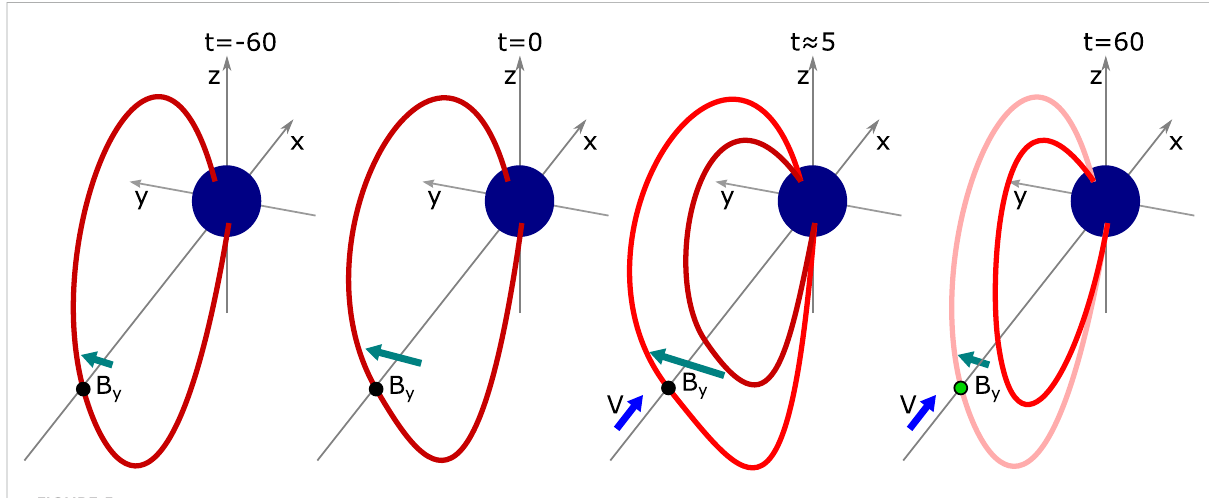
FIGURE 5 Con fi guration of magnetic fi eld lines in the magnetotail at different stages of the substorm. There is a small positive B y component at geosynchronous orbit (dark red fi eld line) when the loading phase commences ( t = − 60 min). This B y component increases gradually until substorm onset( t =0 min)duetoincreasedlobepressure.Intheinitialunloadingphase, B y increasesevenmoreduetopileupofmagnetic fl uxandtransportof more asymmetric fi eld lines (pure red) into geosynchronous orbit ( t ≈ 5 min). The induced B y then decreases, as newly closed fi eld lines (light red) enter geosynchronous orbit and the lobe pressure is reduced ( t = 60